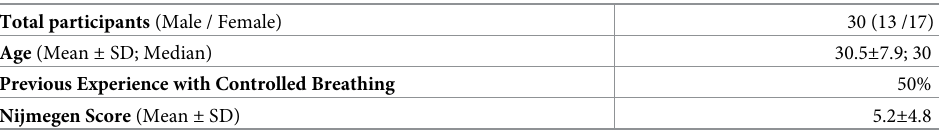
Table 1. Pilot trial participant characteristics (n =